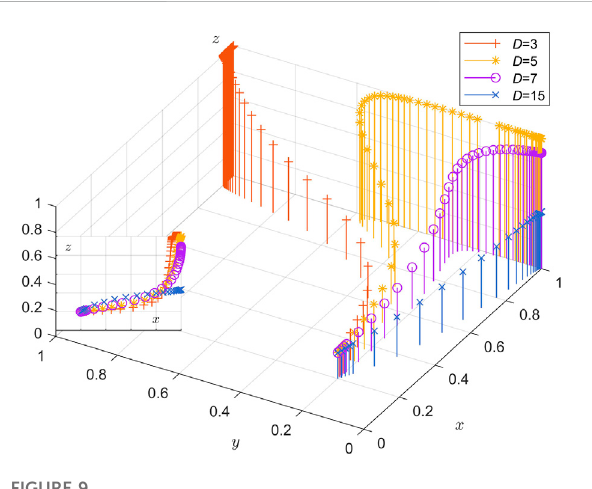
Impact of a carbon tax D on stakeholder behavior